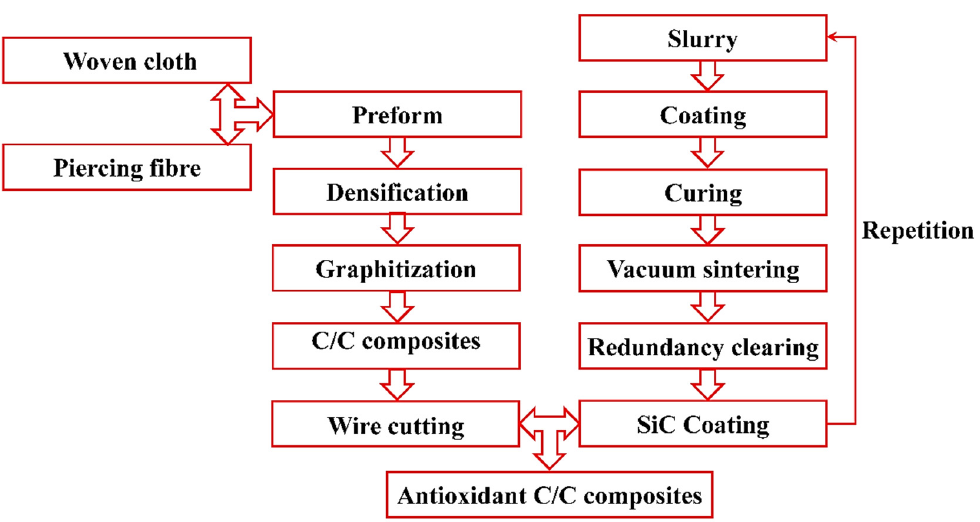
Figure 3. Layer structure of the C/C composites ( a ) and braiding pattern of the pre-fabricated part ( b ).